Question: Which visualization type does this figure use?
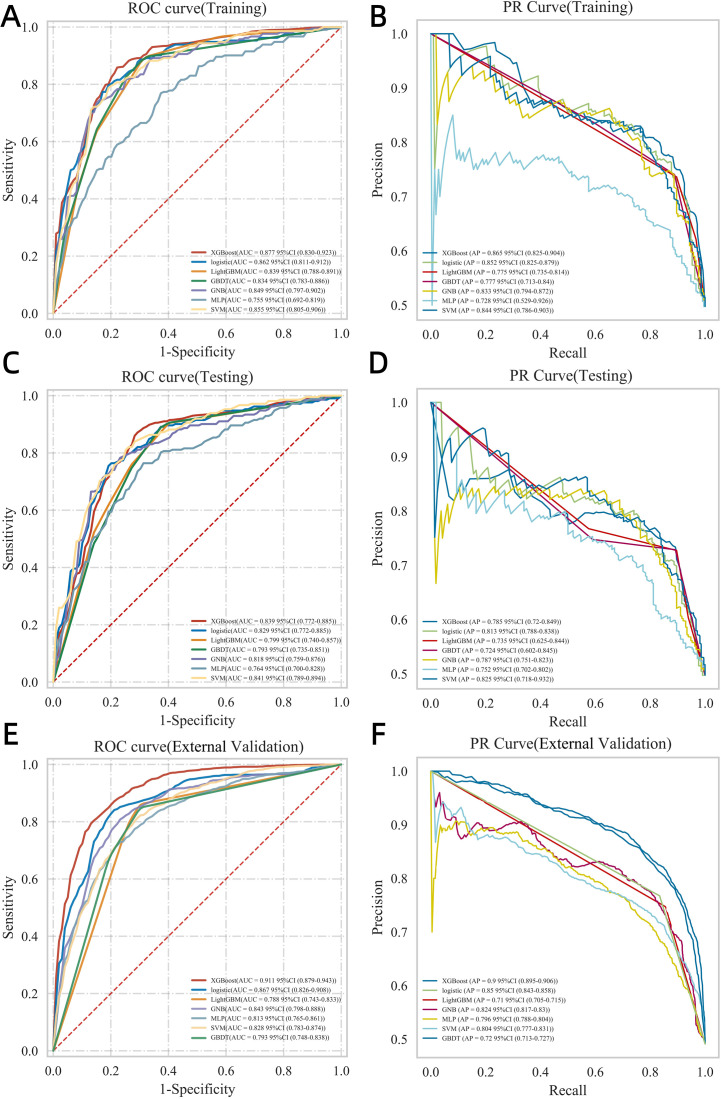
Answer: line